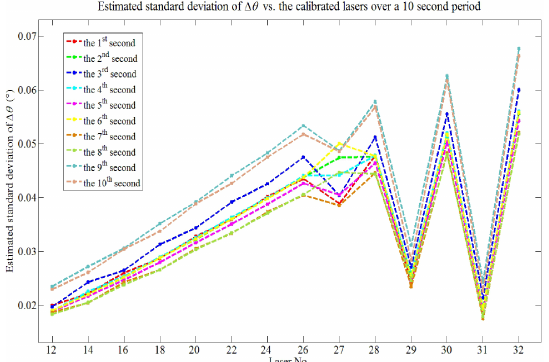
Figure 13. The estimated Δ θ by the calibration for Dataset 1 over a 10 second period